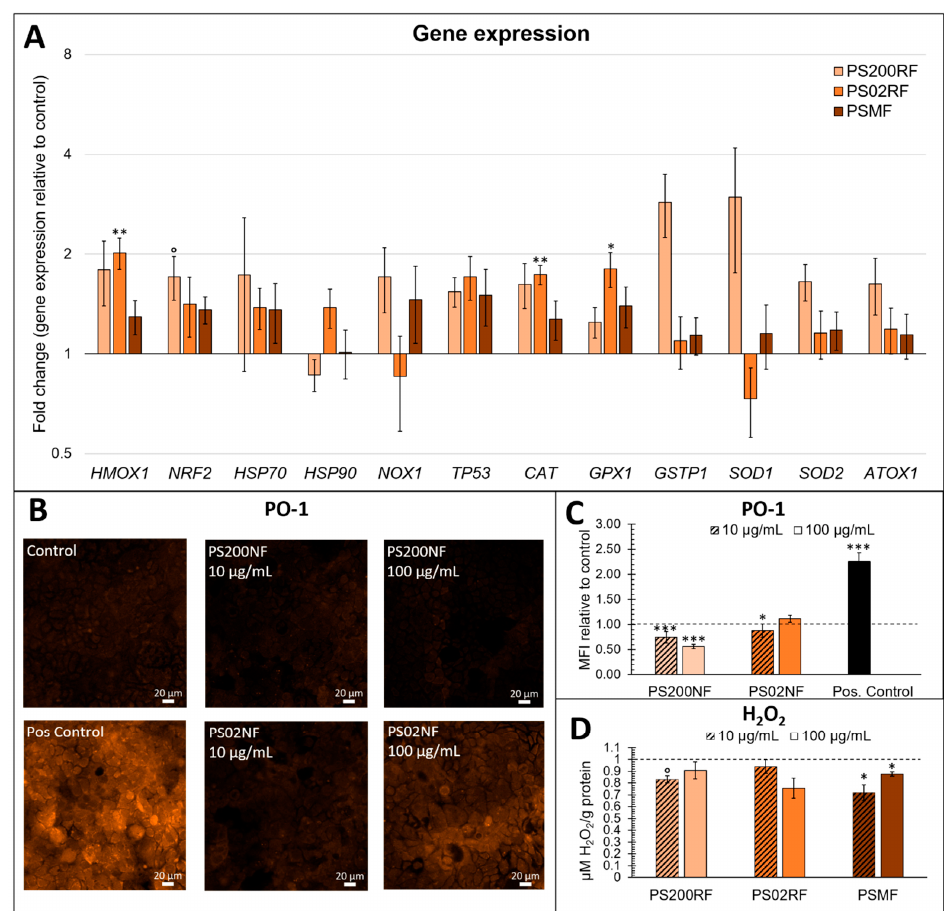
Figure 4. Effects of PS-MPs on oxidative stress responses in a Caco-2 monolayer. ( A ) Gene expression of oxidative stress-related genes after 24 h of exposure to 0 and 100 µg/mL PS200RF, PS02RF, and PSMF in a Caco-2 monolayer. Results represent the fold change expression to control ± standard error to the mean (SEM) (above 1 means up-regulated, below 1 means down-regulated). The fold changes of genes were normalised using three reference genes (Beta-2 microglobulin, Ribosomal protein P0, and Ubiquitin C). n = 10–17 from three independent experiments. One-way ANOVA with control using Dunnett’s method or nonparametric comparison with control using Dunn method for joint ranking was used to assess significance. ° p < 0.1, * p < 0.05, ** p < 0.01. ( B ) Repre- sentative confocal laser scanning microscopy (CLSM) images of hydrogen peroxide (H 2 O 2 ) anions detected in a Caco-2 monolayer after 24 h of exposure to 0, 10, and 100 µg/mL PS200NF and PS02NF using Peroxy-orange 1 (PO-1) live staining on CLSM. Addition of 300 µ M H 2 O 2 on the Caco-2 monolayer was used as positive control. ( C ) Fluorescence intensity of H 2 O 2 anions based on PO-1 staining recorded by CLSM at 20 × magnification. Results represent mean fluorescence intensity (MFI) ± SEM from 2 independent experiments ( n = 5 random circles of ± 500 µ m diameter/image based on 2 images per condition). Statistical significance was assessed by one-way ANOVA with con- trol using Dunnett’s method. * p < 0.05, *** p < 0.001. ( D ) H 2 O 2 levels detected in a Caco-2 monolayer after 24 h of exposure to 0, 10, and 100 µ g/mL PS200NF, PS02NF, and PSMF based on quantitative 10-Acetyl-3, 7-dihydroxyphenoxazine/horseradish peroxidase (ADHP/HRP)-based assay. Results represent average H 2 O 2 levels ( µ M/g protein) ± SEM relative to control ( n = 6 from 2 independent experiments). Nonparametric comparison with control using Dunn method for joint ranking was used to assess statistical significance. ◦ p < 0.1, * p <